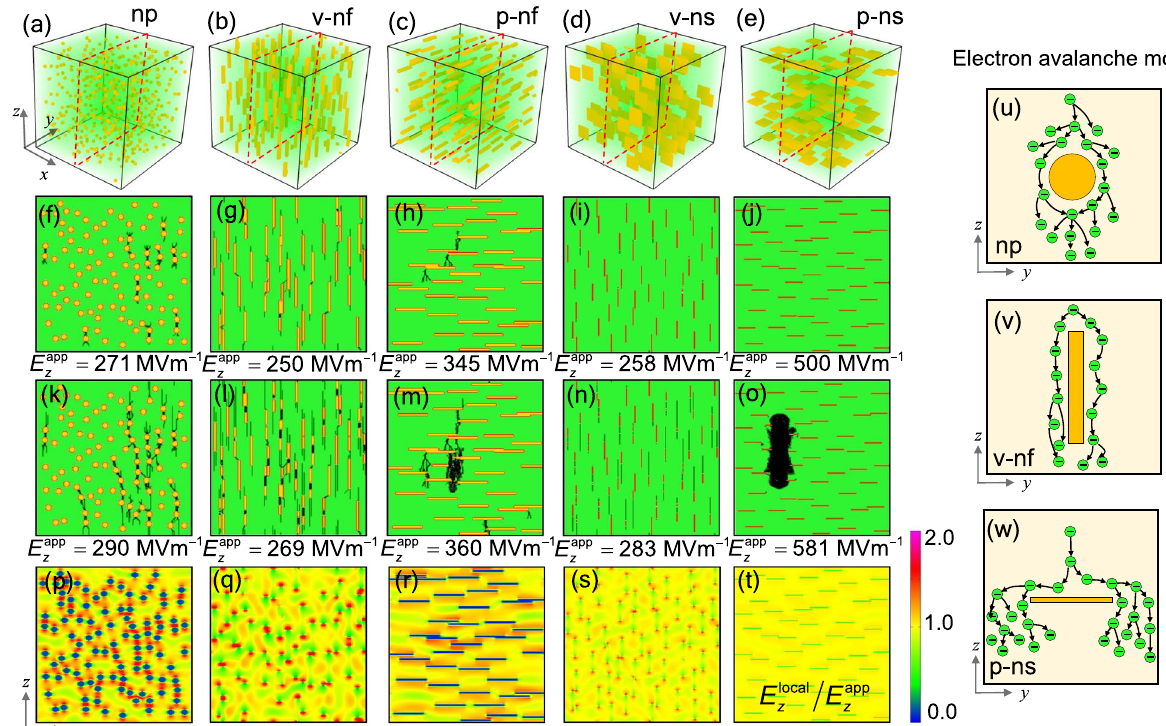
Fig. 3 The nano fi ller effect on the breakdown process of polymer nanocomposites. Microstructural diagrams of polymer nanocomposites with ( a ) random nanoparticles, ( b ) vertical nano fi bers, ( c ) parallel nano fi bers, ( d ) vertical nanosheets, and ( e ) parallel nanosheets at the volume fraction of 1%. ( f – o ) Corresponding breakdown paths under different electric fi elds along the cross-section. ( p – t ) The distributions of the local = E app . ( u – w ) Illustrations of possible electron avalanche modes in different polymer electric fi eld E local z z